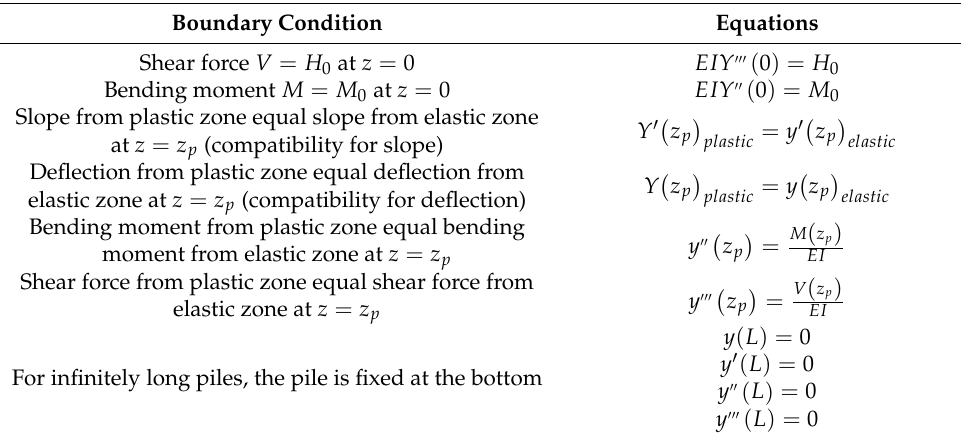
Table 2. Boundary conditions used for elasto-plastic